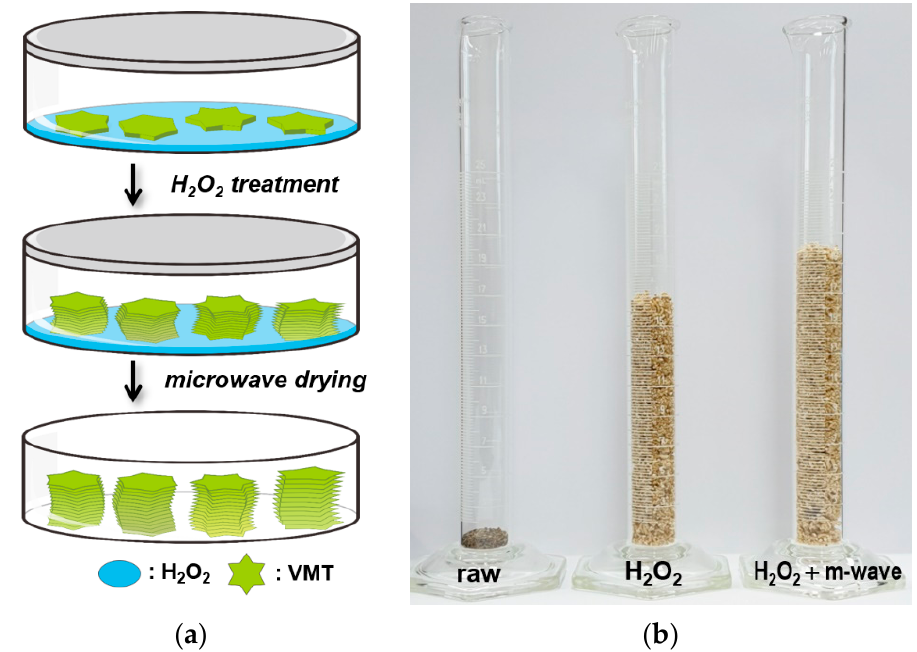
Figure 1. ( a ) Schematic diagram of the two-step process used for the preparation of highly expanded vermiculite. ( b ) Photographs displaying 1 g of vermiculite: non-expanded raw sample (left), expanded samples taken after the first H 2 O 2 treatment (middle) and the second microwave drying (right).